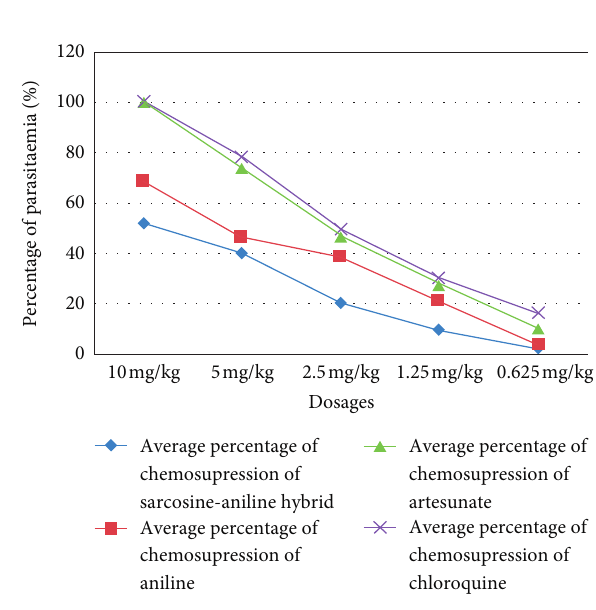
Figure 6: Percentage of parasitaemia chemosupression of sarco- sine-aniline hybrid. Table 2: ED 50 of sarcosine-aniline hybrid versus control drugs